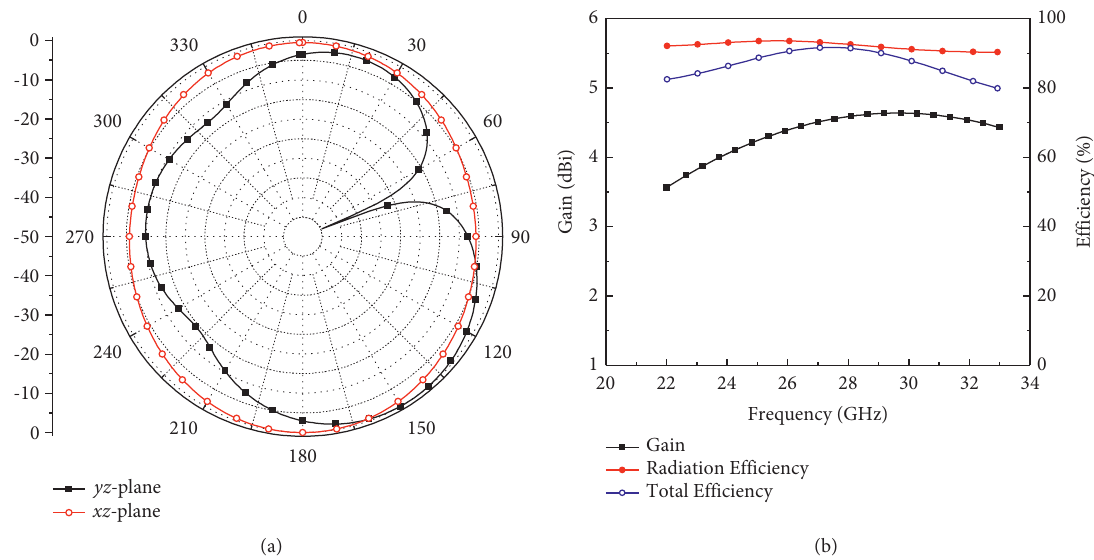
Figure 4: Simulated (a) radiation characteristics, (b) gain, radiation efficiency, and total efficiency of the proposed fractal